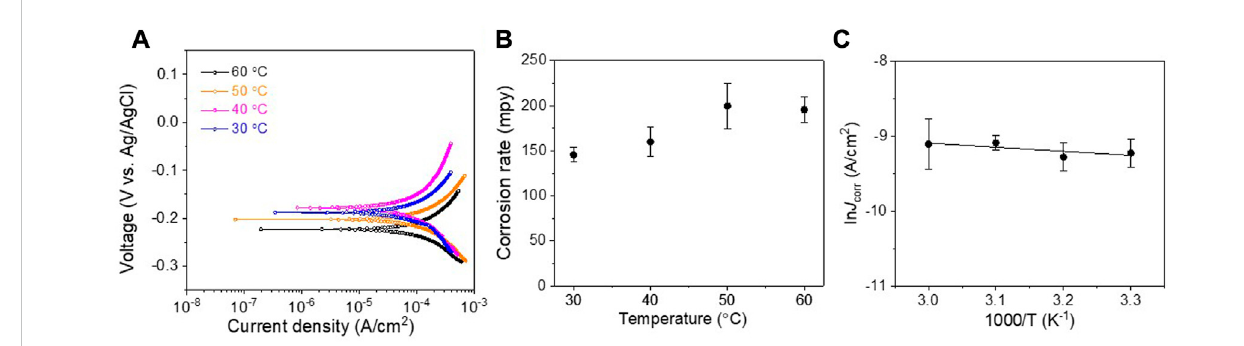
FIGURE 7 (A) Potentio-dynamicpolarizationcurvesofthepartlygold-coatedSCCYin1 MNaClsolutionat30,40,50,and60 ° C,respectively. (B) Thecorrosion rate and (C) Arrhenius plot of ln i corr vs. 1000/T for the partly gold-coated SCCY.